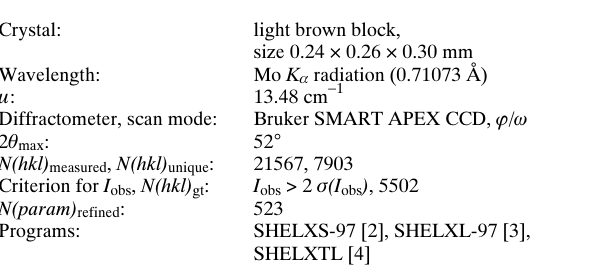
Table 1. Data collection and